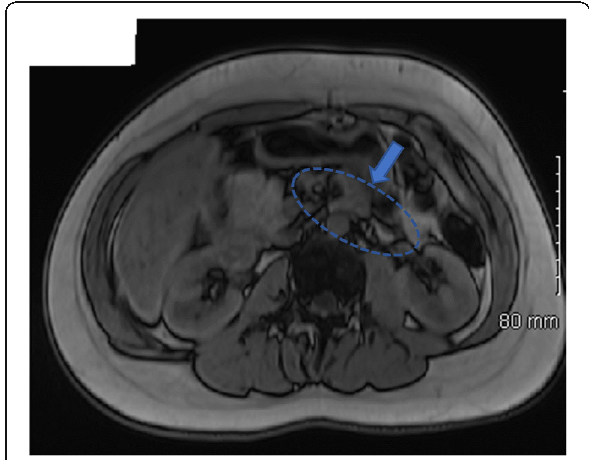
Fig. 2 Abdominal MRI axial and coronal image revealing the absence of most of the neck, body and tail of